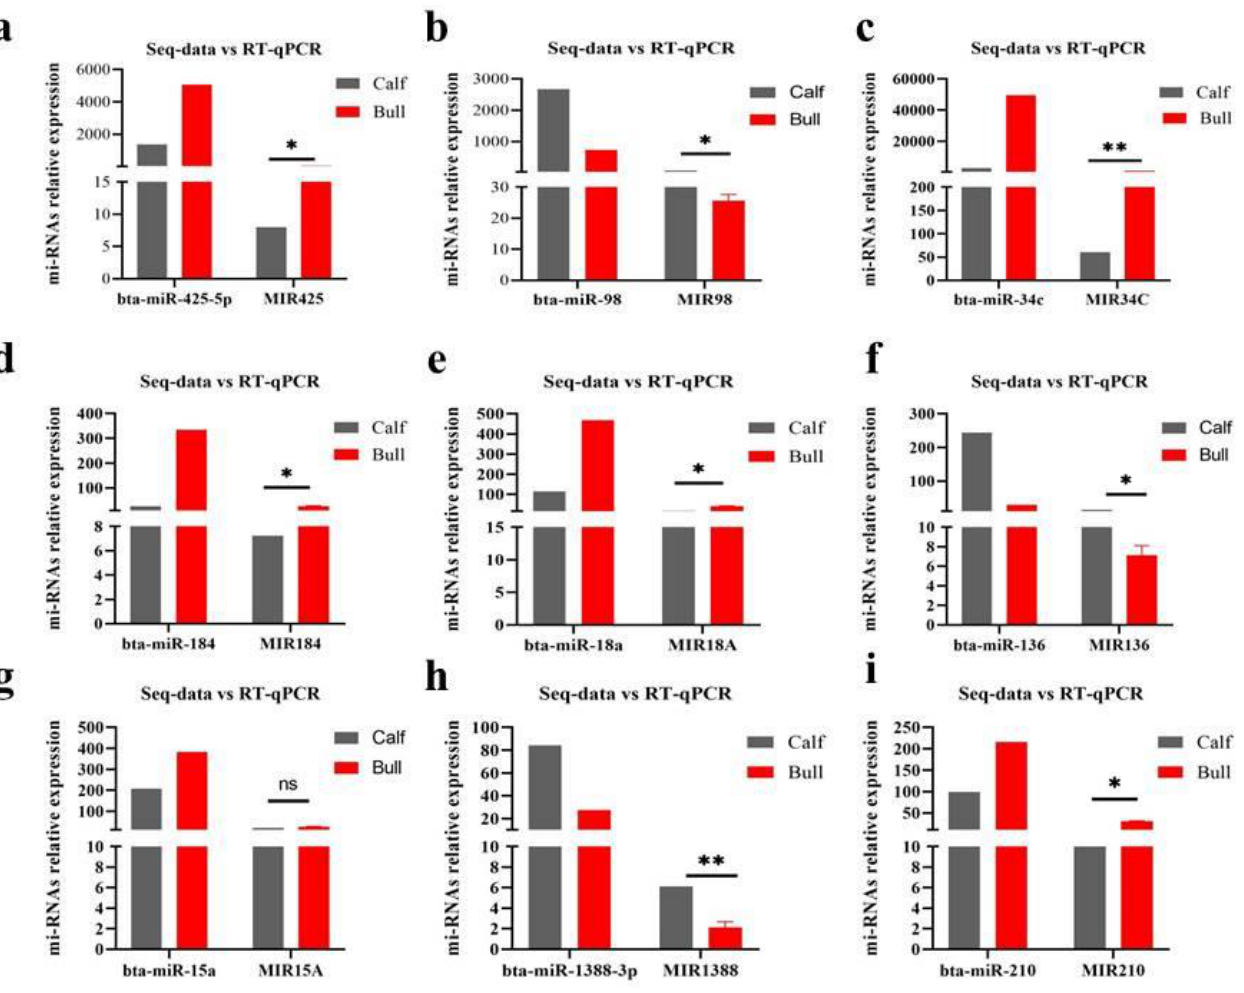
Figure 8. Validation of DE miRNAs via RT-qPCR was performed. ( a – i ) Shows the expression patterns of nine DE miRNAs (MIR425, MIR98, MIR34C, MIR184, MIR18A, MIR136, MIR15A, MIR1388, and MIR210) in bull and calf groups. The data were assessed by the 2 − ∆∆ Ct method with the U6 small nuclear RNA as an internal standard. The data are presented as the MEAN ± SEM; * p < 0.05, ** p < 0.01.